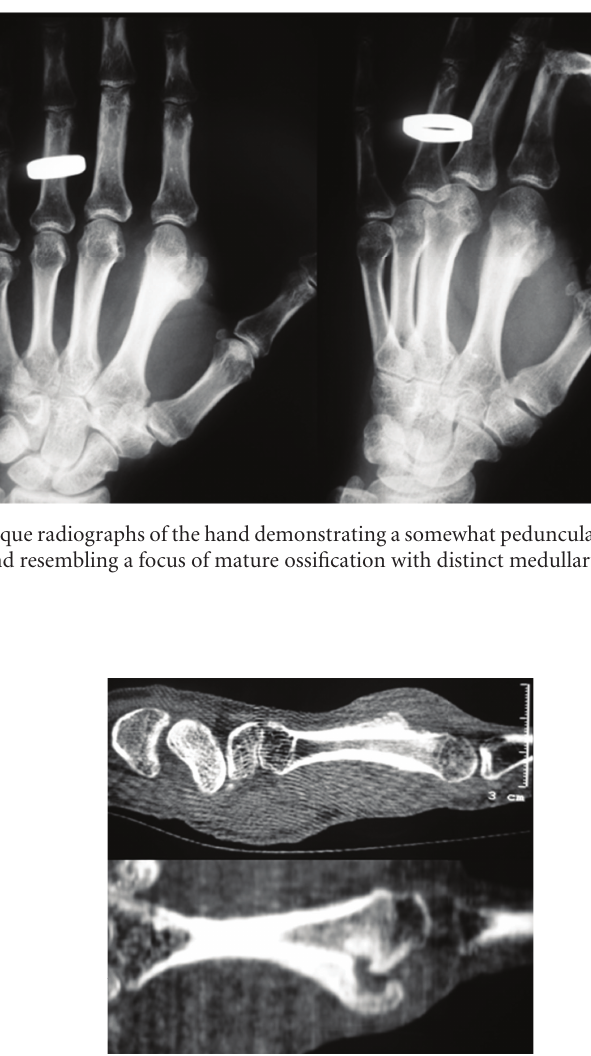
Figure 14: CT sagittal images of the second metacarpal demonstrating saucerization of the underlying cortical bone.